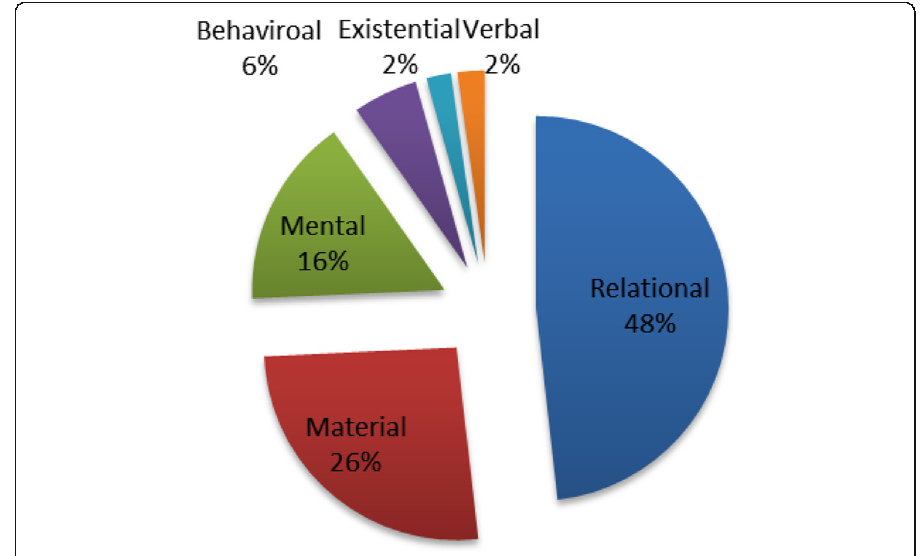
Fig. 2 Overall deployment of process types in students ’ writing